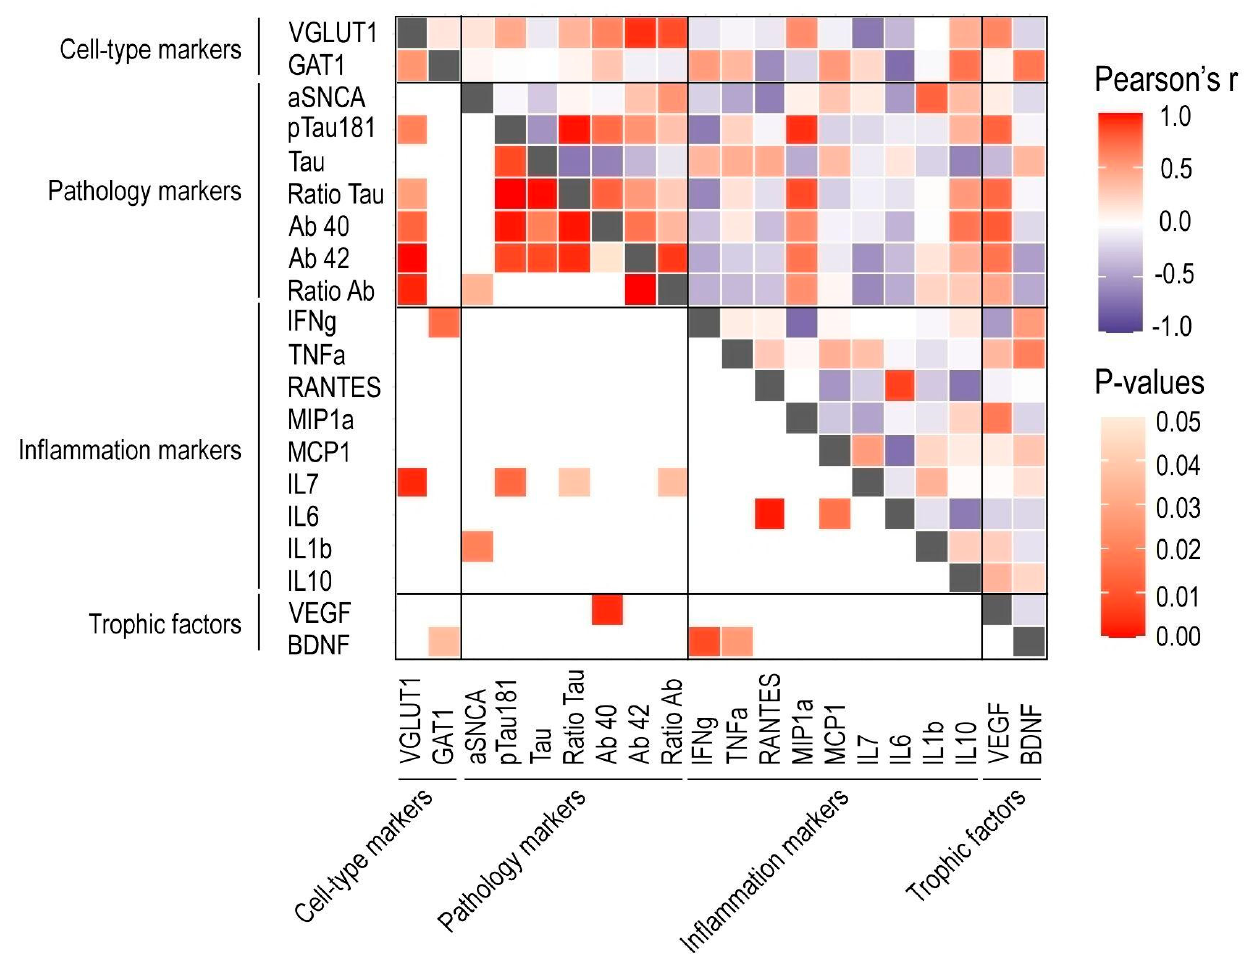
measured by Luminex were checked for correlations with VGLUT1 and GAT1 area fractions. Since protein levels were measured in homogenized hippocampi, the correlations were performed only with ISH marker data from the total hippocampus and not in a region- specific manner. A correlation matrix summarizing all associations is presented in Figure 6.